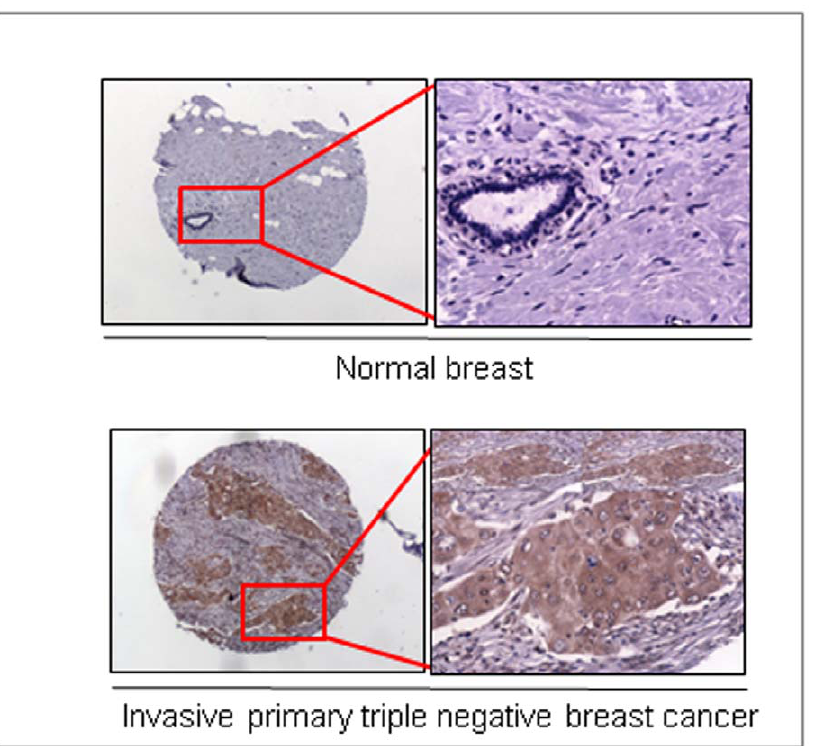
Figure 6. Differential over-expression of MUC4 mucin in TNBC tissues compared with normal breast tissues. Immunohistological analyses were performed using the anti-MUC4 mouse monoclonal antibody (2214, generated in our laboratory, against a sequence close to the N- terminus of human MUC4) on tumor microarrays (BR1503 and BR10010) containing normal breast and invasive TNBC tissues and observed under a Nikon light microscope. MUC4 expression in invasive primary (n=35) TNBC tissues were compared with normal breast tissue (n=6) in a set of arrays. High immune-reactivity for MUC4 was detected in invasive TNBC tissues, but not in normal breast tissues. The image presented was taken at 4 6 magnification, and the higher magnification images (marked with a red box) were taken at 10 6